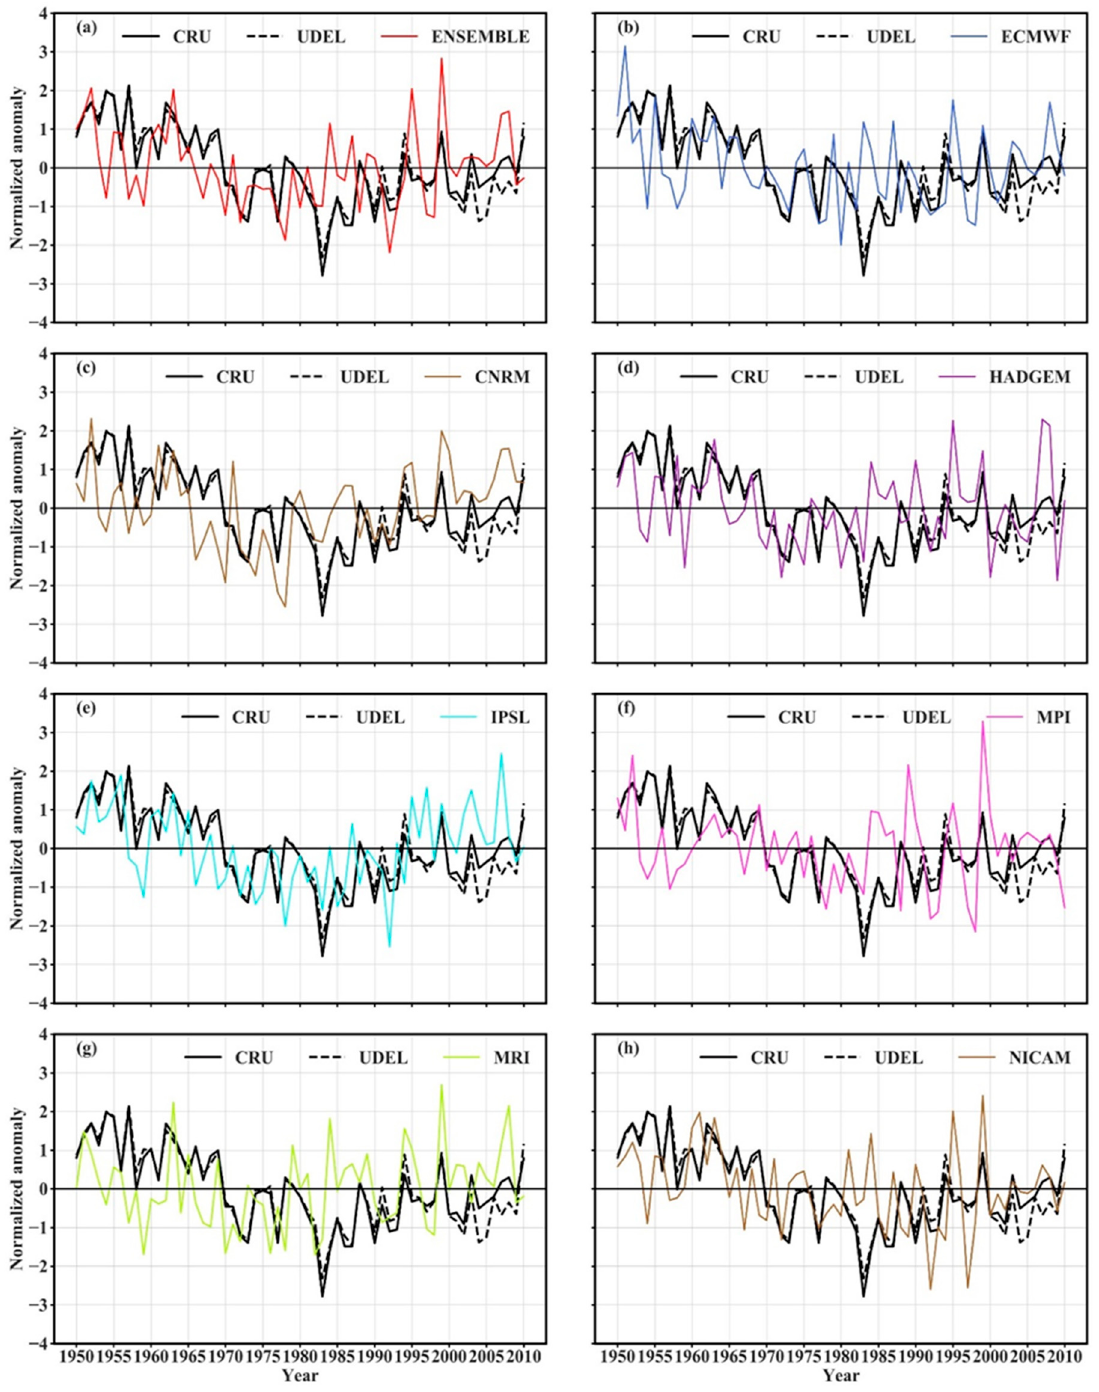
Figure 6. The standardized precipitation anomaly in the simulation of ( a ) ensemble mean, ( b ) ECMWF, ( c ) CNRM, ( d ) HADGEM, ( e ) IPSL, ( f ) MPI, ( g ) MRI, and ( h ) NICAM models over West Africa. The observed results from CRU TS v.4.03 and UDEL v.5.01 are superimposed for comparison.